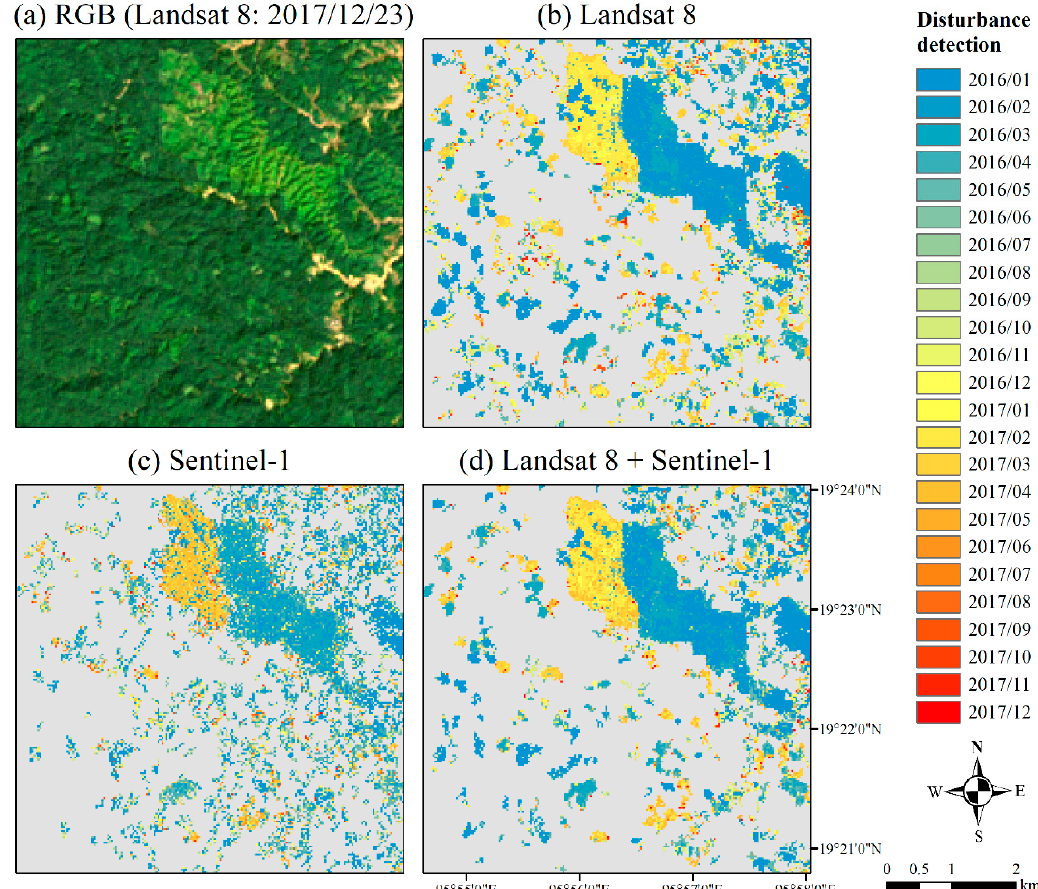
Figure 7. Example of disturbance detection in the study area. ( a ) RGB Landsat 8 data acquired on 23 December 2017, ( b ) disturbance detection using Landsat 8, ( c ) disturbance detection using Sentinel-1 and ( d ) disturbance detection using Landsat 8 and Sentinel-1. Disturbance pixels that had greater than 0.5 ha minimum mapping unit were used for visualization.